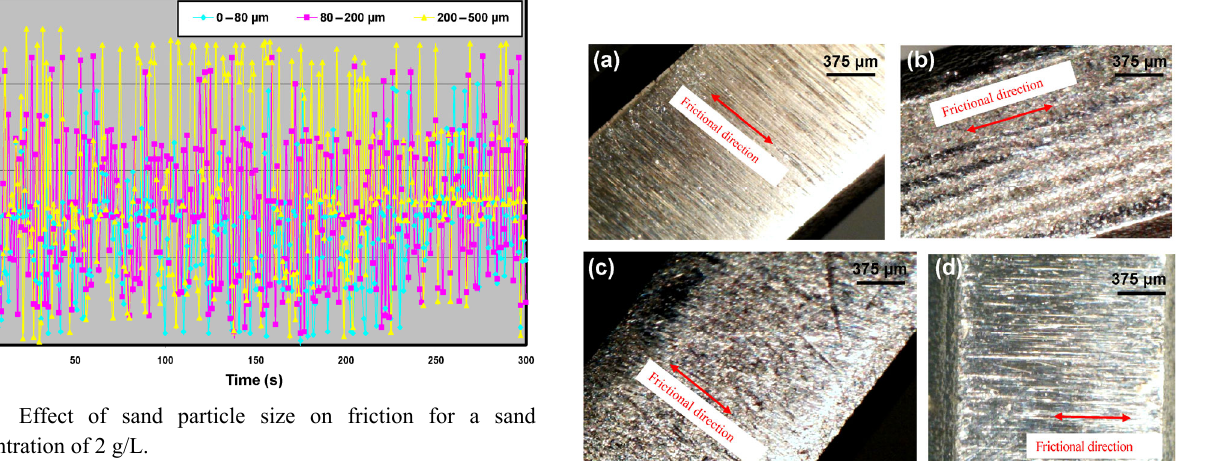
Fig. 10 Effect of sand contamination in lubricant on wear for sand particles of size 0–80 µm.